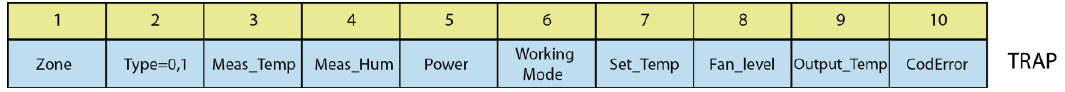
Figure 7. Structure of the trap message.